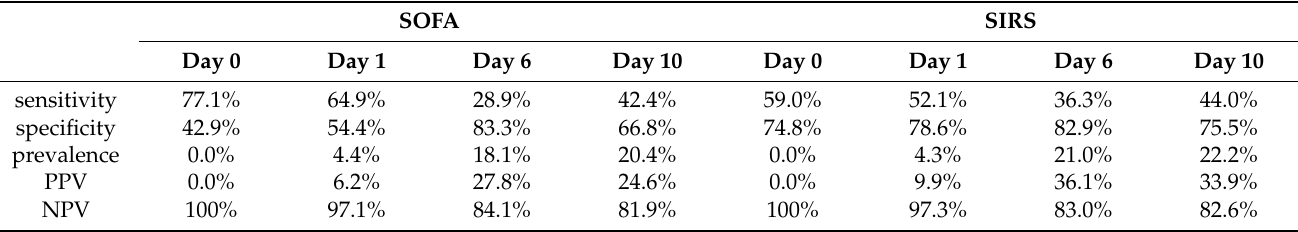
Table 2. Sepsis detection via SOFA score in